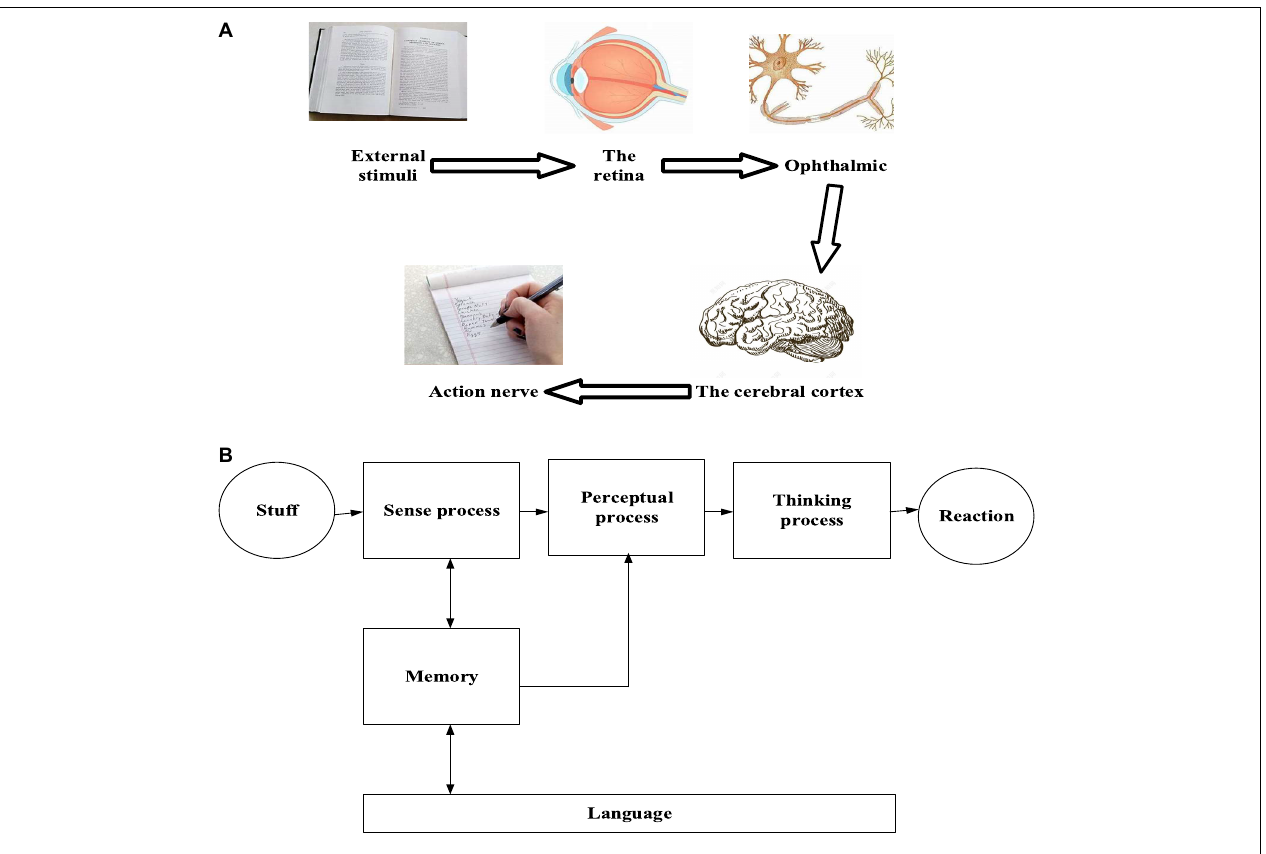
FIGURE 1 | Cognitive process of human beings (A) physiological process (B) thinking